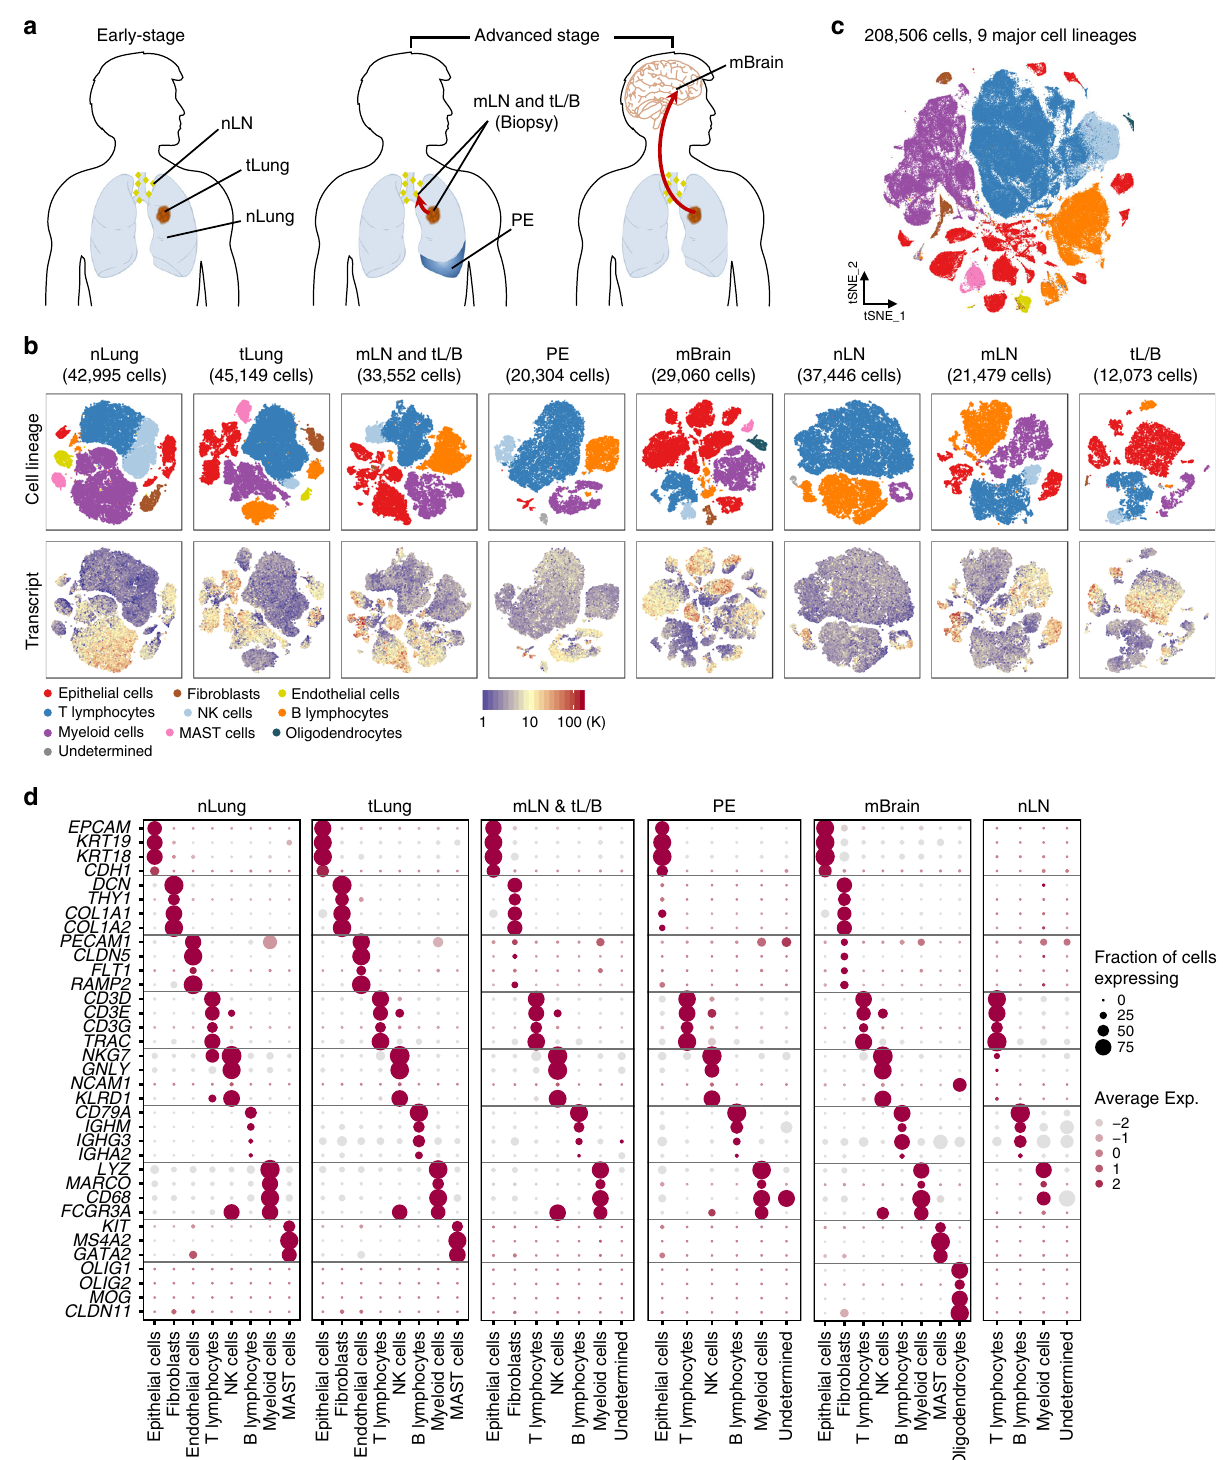
Fig. 1 Comprehensive dissection and clustering of 208,506 single cells from LUAD patients. a Overview of tissue origins in the present study collection. Single-cell RNA sequencing was applied to cancer tissue-derived whole cells from primary sites (tLung and tL/B), pleural fl uids (PE), lymph node (mLN), and brain metastases (mBrain), as well as normal tissues from lungs (nLung) and lymph nodes (nLN). b tSNE projection within each tissue origin, color- coded by major cell lineages and transcript counts. c tSNE plot of 208,506 single cells colored by the major cell lineages as shown in ( b ). d Dot plot of mean expression of canonical marker genes for nine major lineages from tissues of each origin, as